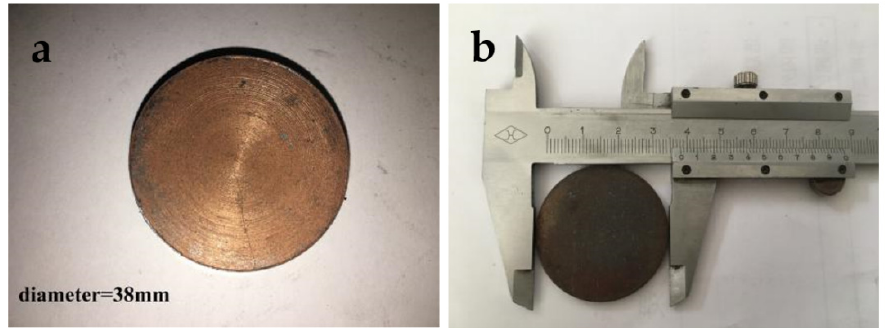
Figure 1. Pictures showing diamond/Cu composite samples: ( a ) cold pressed sample and ( b ) as-fabricated composite.